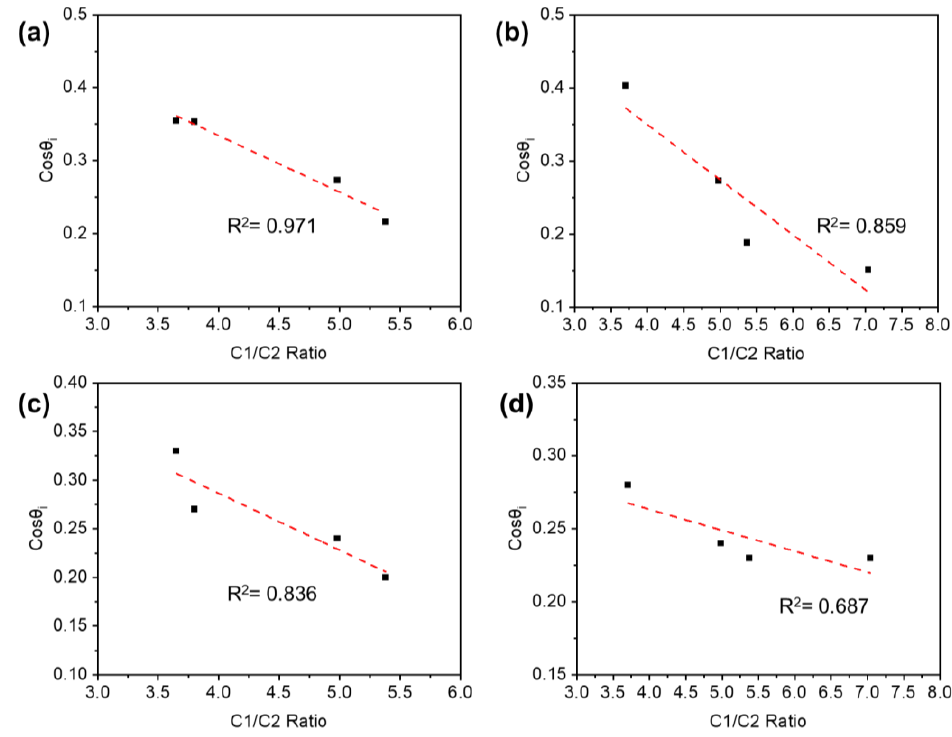
Figure 8. Relationship between initial wettability tested by water and the C1/C2 ratio of the TPM- treated veneer with different temperatures ( a ) and durations ( b ), and tested by PF resin and the C1/C2 ratio of the TPM-treated veneer with different temperatures ( c ) and durations ( d ).